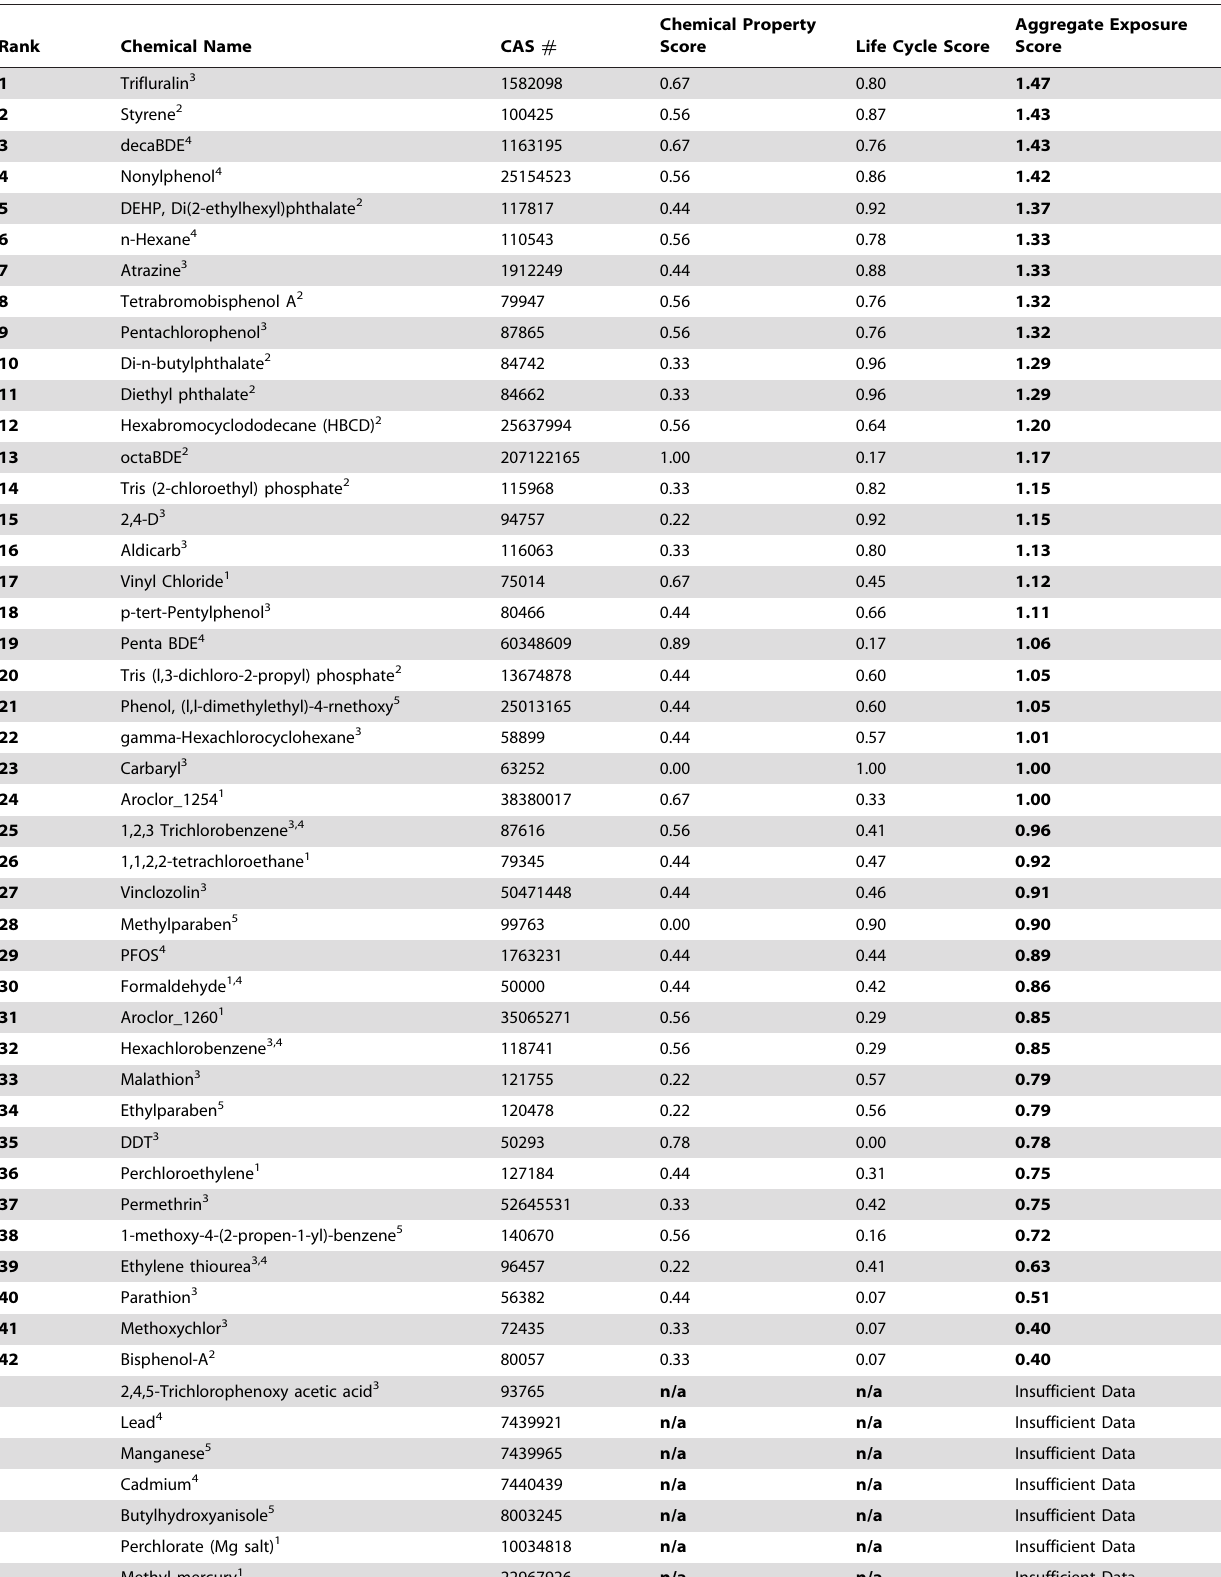
Table 4. Exposure Rankings with Even